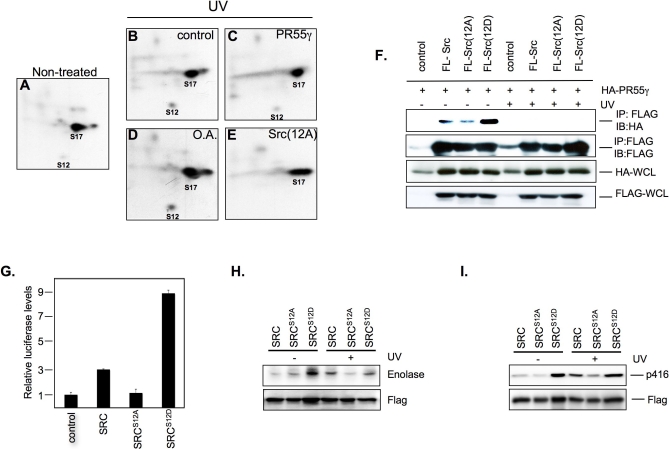
PR55γ Regulates Serine 12 Phosphorylation on c-SRC(A) Phosphotryptic pattern of U2-OS cells expressing c-SRC from untreated cells.(B–E) Phosphopeptides of c-SRC following treatment with UV (100 J/ m2) for 30 min in the presence of 2 mCi [32P]orthophosphate (B), c-SRC plus PR55γ (C), c-SRC pretreated for 1 h with 1 μM okadaic acid (D), and Ser12A mutant (E). Phosphorylated c-SRC was immunoprecipitated, and samples were subjected to phosphopeptide mapping as described under “Materials and Methods”.(F) U2-OS cells were transfected as indicated. 48 h after transfection cells were treated with UV (100 J/m2) and incubated for a further 120 min. Cells were lysed in ELB, and equal amounts of cell lysate (500 μg) were immunoprecipitated using a FLAG antibody (Sigma). Coimmunoprecipitated HA-tagged PR55γ was detected with an HA antibody. Whole cell lysates (WCL) were probed using FLAG or HA antibodies to detect transfected protein.(G) U2-OS cells expressing a 5× AP1-luciferase construct (pGL2), Flag-SRC, Flag- SRCS12A, Flag- SRCS12D, or control vector as indicated. Luciferase counts are shown relative to the control.(H) U2-OS cells were transfected as indicated. At 48 h after transfection cells were washed twice in PBS and incubated for a further 72 h in medium without FCS. Cells were treated with UV (200 J/m2) and incubated for a further 30 min in the same medium. Equal amounts of cell lysate (500 μg) were immunoprecipitated with α-Flag antibody and in vitro kinase assays were performed using enolase as a substrate.(I) U2-OS cells were transfected as indicated. At 48 h after transfection cells were washed twice in PBS and incubated for a further 72 h in medium without FCS. Cells were treated with UV (200 J/m2) and incubated for a further 30 min in the same medium. Equal amounts of cell lysate (500 μg) were immunoprecipitated with α-Flag antibody and analyzed by western blot for either tyrosine phosphorylation at residue 416 (top panel) or FLAG (bottom panel).doi:10.1371/journal.pgen.0030218.g007